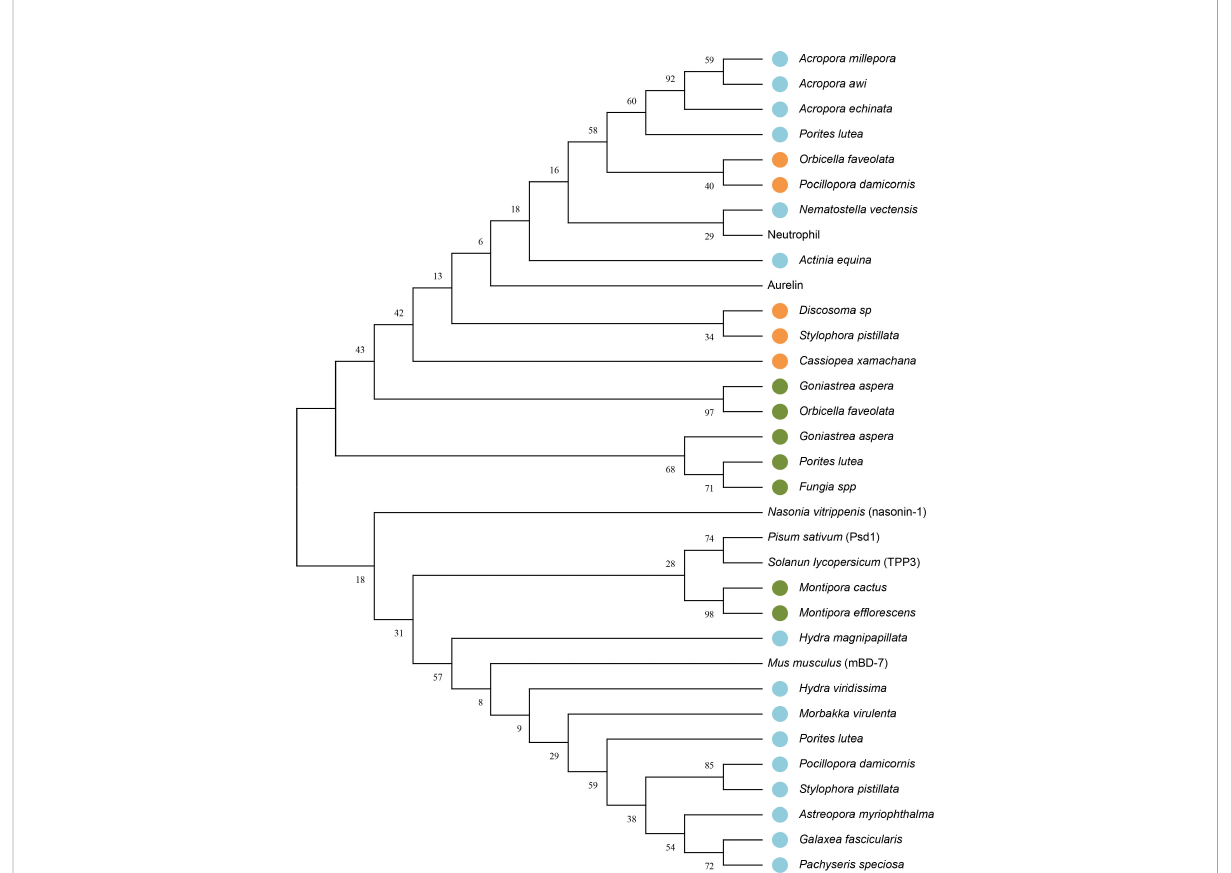
FIGURE 3 Phylogenetic tree with putative sequences for AMPs from Cnidaria. The bootstrap consensus tree unrooted inferred from 1000 replicates using the Maximum Likelihood method and the model based on the Dayhoff matrix (Schwarz and Dayhoff, 1979). This analysis involved 33 amino acid sequences. The percentage of replicate trees in which the associated taxa clustered together in the bootstrap test (1000 replicates) is shown next to the branches. Initial tree(s) for the heuristic search were obtained automatically by applying the Neighbor-Join and BioNJ algorithms to a matrix of pairwise distances estimated using the Dayhoff model and then selecting the topology with a higher log-likelihood value. A discrete Gamma distribution was used to model the evolutionary rate differences between sites (5 categories (+G, parameter = 5.6968)). There was a total of 56 positions in the fi nal data set. Blue circles represent peptides that showed putative antimicrobial activity against multiresistant bacteria, orange circles represent peptides that showed putative antimicrobial activity and were structurally characterized; and green circles represent peptides that were only structurally characterized. Evolutionary analyzes were performed in MEGA11 (Tamura et al.,